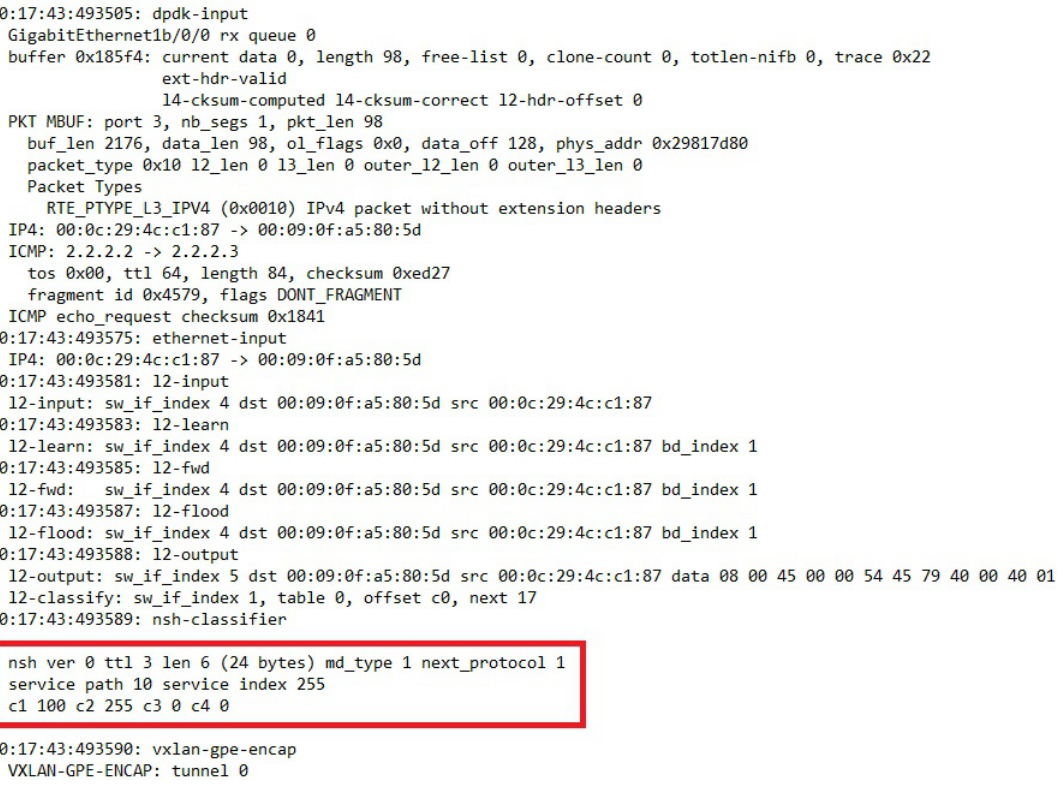
Figure 26. NSH packet